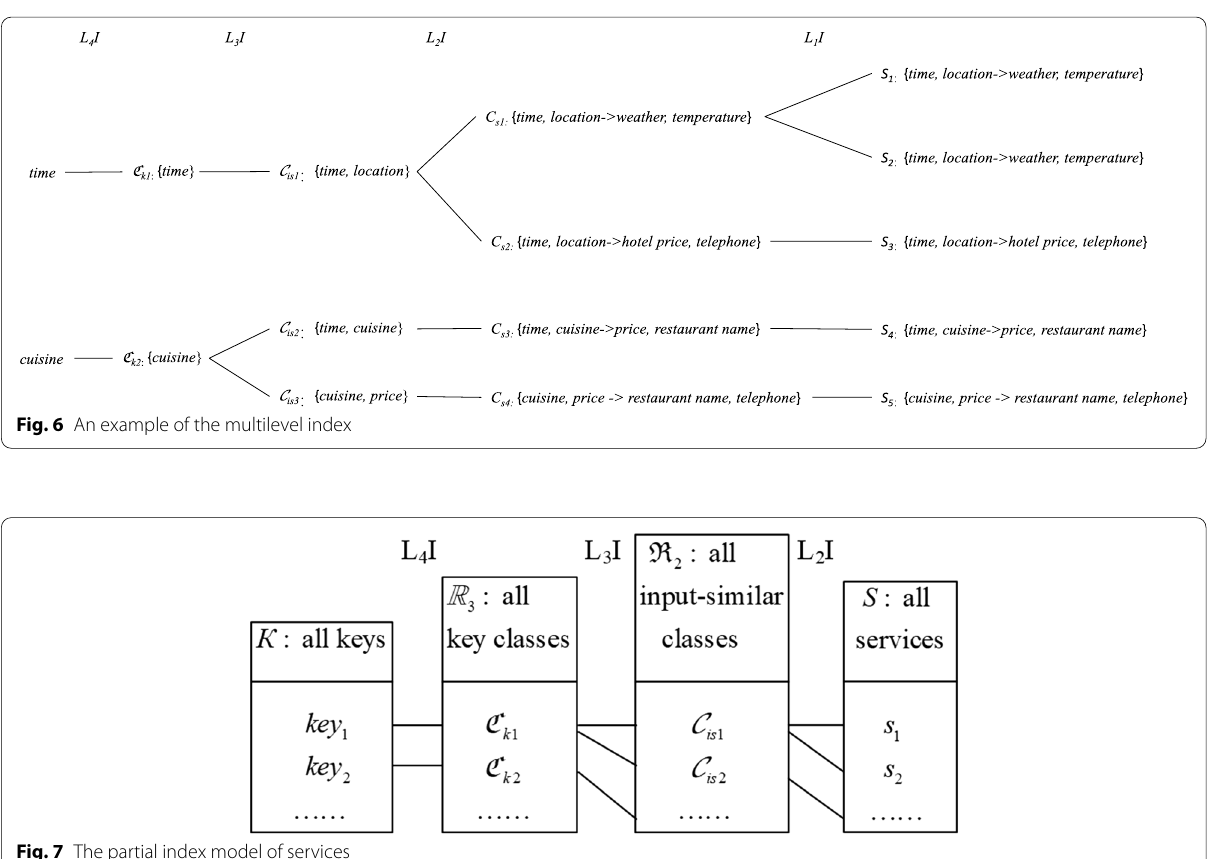
Fig. 7 The partial index model of services